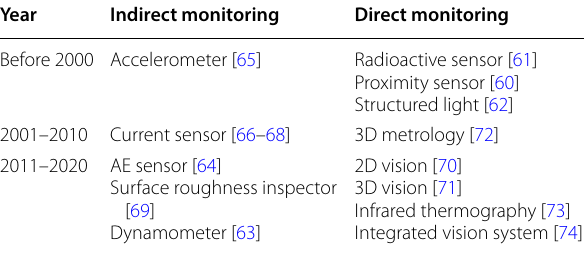
Table 3 Evolution of tool condition